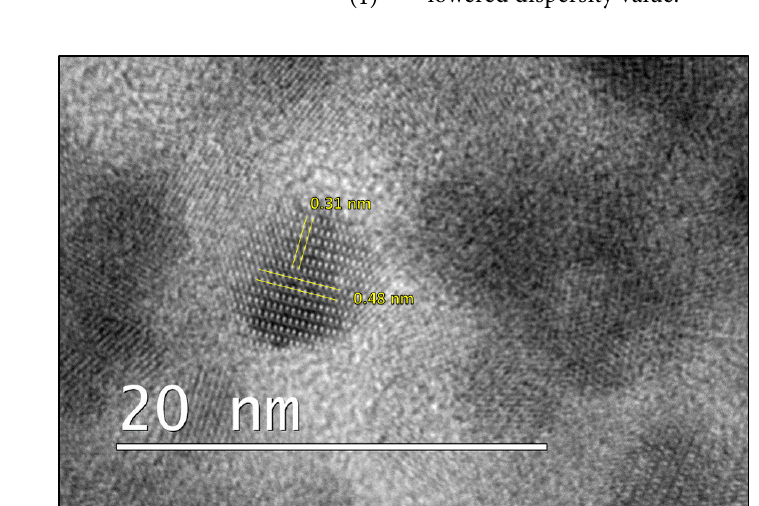
Fig. 4. High resolution TEM micrograph of the SimQ nanoparticle sample, demonstrating the crystallinity of the nanoparticles